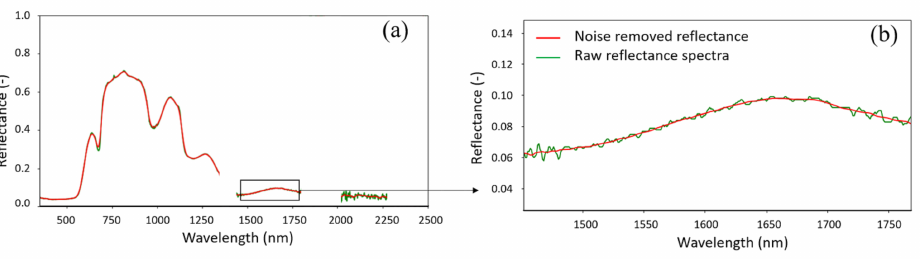
Figure 5. ( a ) Raw hyperspectral reflectance spectra (green) of a strawberry fruit and its smoothed version (red). ( b ) Zooming in the reflectance spectra indicated within a box in panel ( a ), which highlights the effect of the Savitzky–Golay filter at relatively less noisy parts of the